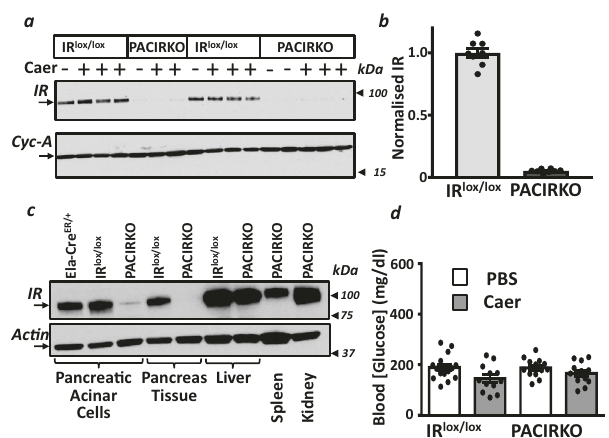
Fig. 2 PACIRKO mice that lack pancreatic acinar cell insulin receptors are normoglycaemic. a Insulin receptor (IR) expression (western blot using anti-IR β antibody) in pancreas tissue from double fl oxed insulin receptor (IR lox/lox ) mice vs Pancreatic Acinar Conditional Insulin Receptor Knock Out (PACIRKO) mice following administration of tamoxifen for 4 days (oral gavage or tamoxifen feed) with ( + ) or without ( − ) caerulein (Caer; 50 µ g/ Kg × 8 hourly IP injections over 2 days) to induce acute pancreatitis, or PBS. Western blotting with anti-cyclophilin-A was used as a loading control. IR expression was semi-quanti fi ed by normalizing band intensities to the corresponding cyclophilin-A band and further normalisation to the mean of IR lox/lox ( b ). c IR expression was also compared between lysates from pancreatic acinar cells and tissue from Ela-Cre ER/ + mice, IR lox/lox and PACIRKO and also liver, spleen and kidney tissue. Actin was used as a loading control (lower panel, c ). For each western blot of IR in a , c , the corresponding loading control (cyclophilin-A in a and actin in b ) were from the same gel (membrane cut and incubated with corresponding antibody) and are representative of three separate experiments. d Blood glucose in IR lox/lox vs PACIRKO mice, with caerulein (grey bars) or PBS white